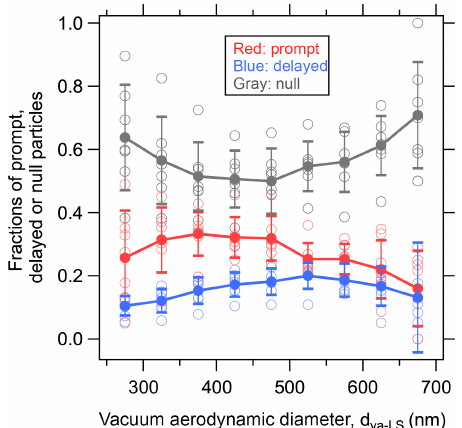
Figure 3. The number fractions of prompt (red), delayed (blue), and null (gray) particles as a function of particle vacuum aerodynamic diameter from the light-scattering module, d va-LS , for flights from 26 June to 8 July during SENEX. Circles represent the average data of each flight. The solid dots and lines represent the average data of these flights. Error bars represent one SD from the average. The flight on 6 July had the lowest null fractions while the flight on 3 July had the highest null